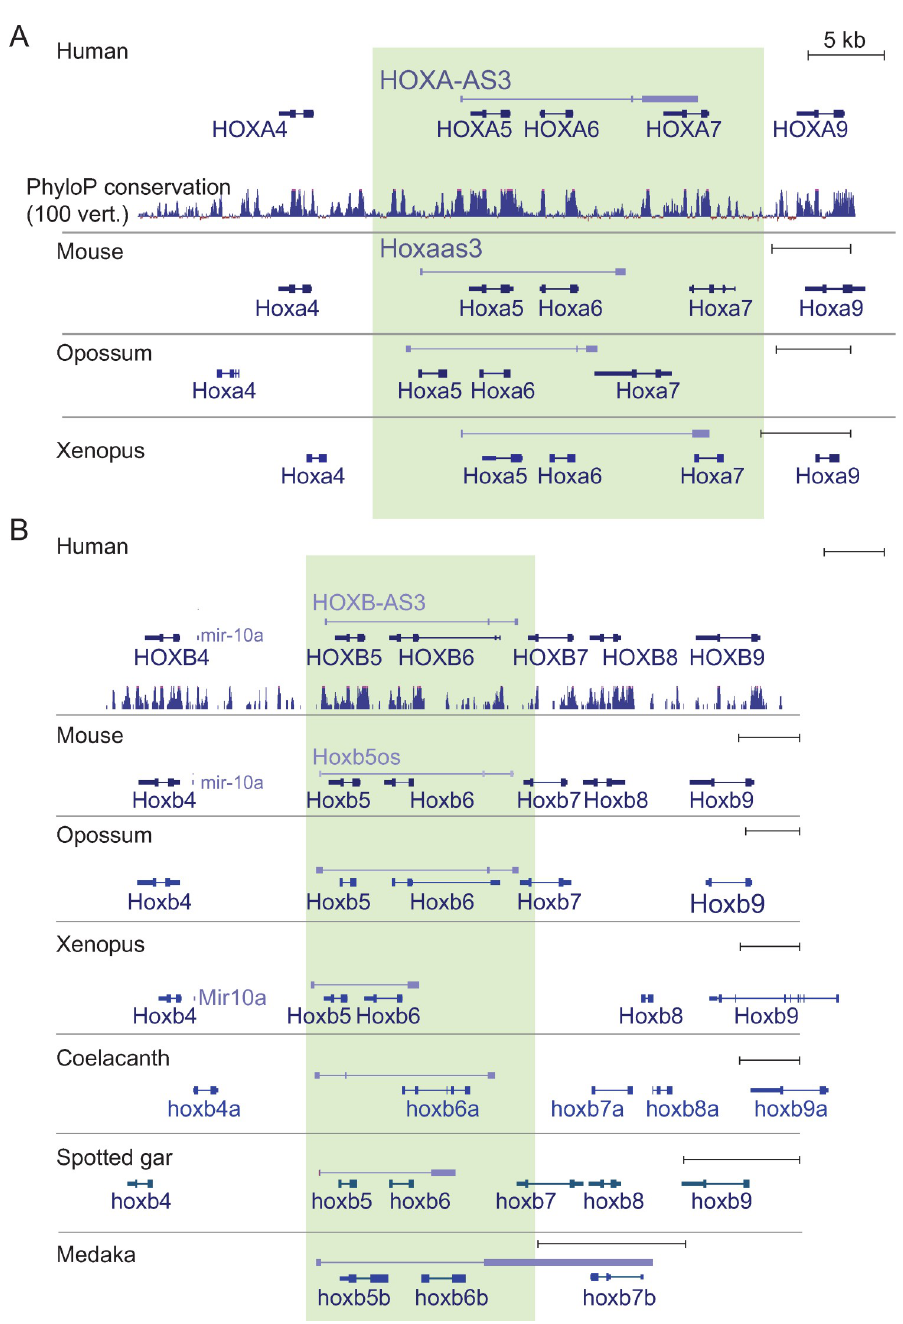
Fig 1. Orthologs of HOXA-AS3 and HOXB-AS3 in different vertebrate species. Transcript models annotated by Ensembl, Refseq, or PLAR [61], or manually reconstructed based on RNA-seq data (see S1 Fig ) for HOXA-AS3 ( A ) and HOXB-AS3 ( B ) are shown alongside the annotated protein-coding genes in the locus. The lncRNAs are transcribed from the ‘+’ strand and all other genes are transcribed from the ‘-’ strand. The regions of HOXA-AS3 and HOXB-AS3 are